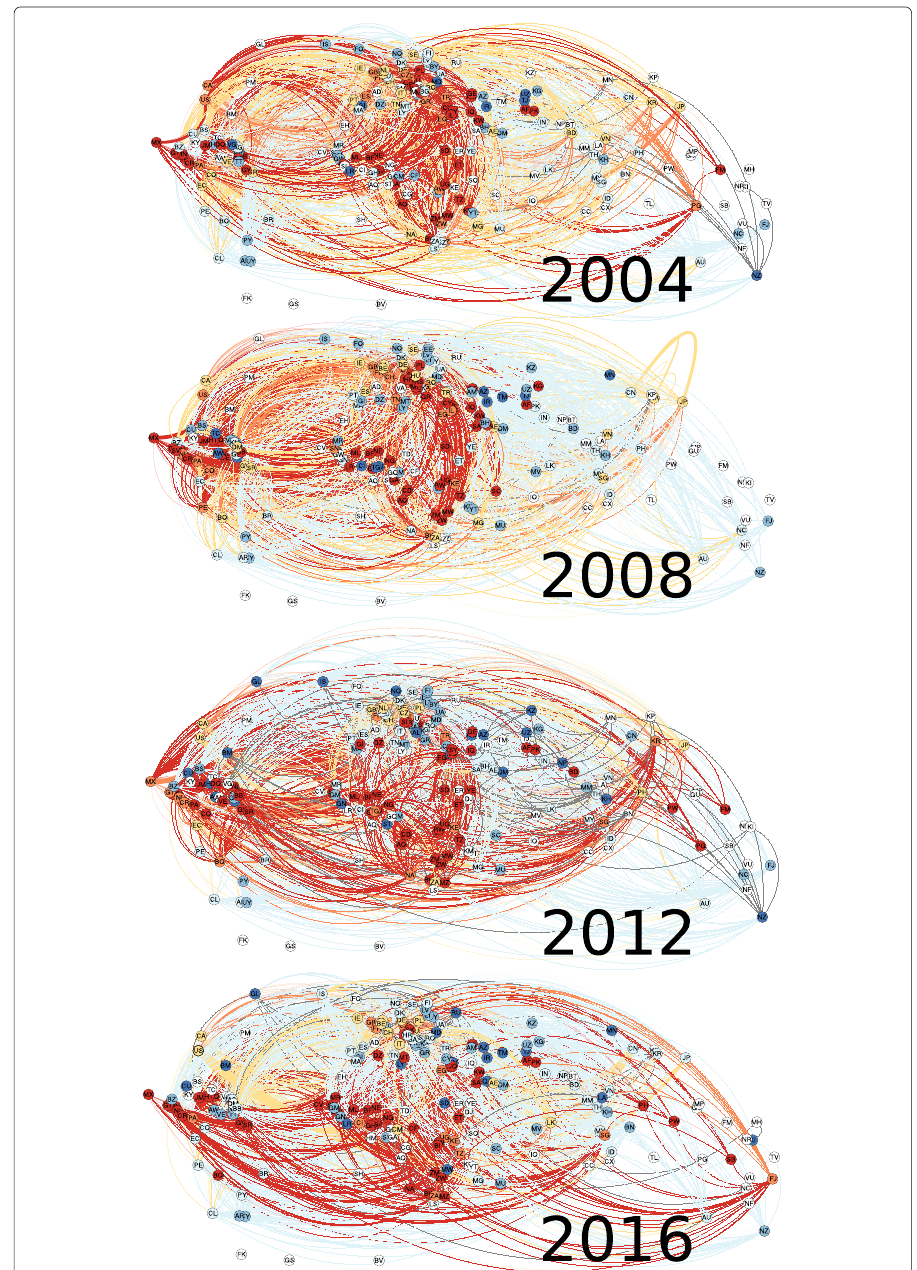
Fig. 8 Crisis contagion network for years 2004, 2008, 2012, and 2016. The colors of country nodes range from red, for countries going to bankruptcy at stage τ = 0, to blue, for countries going to bankruptcy at stage τ = τ ∞ . White nodes corresponds to countries which never go to bankruptcy. The direction of the link between two countries A and B is given by its curvature. If A points to B following the bent path in the counterclockwise direction (A (cid:4) B) then A went to bankruptcy at the stage just before B, otherwise, i.e. (A (cid:3) B), B went to bankruptcy at the stage just before A. The color of the link is the color of the node source. The width of the link is proportional to the export volume from the target country to the source country in the unmodified WTN . Here, once a country goes to bankruptcy, it is prevented to import products with the exception of petroleum and gas (model A). The bankruptcy threshold is κ = 0.1 and the damping factor is α =